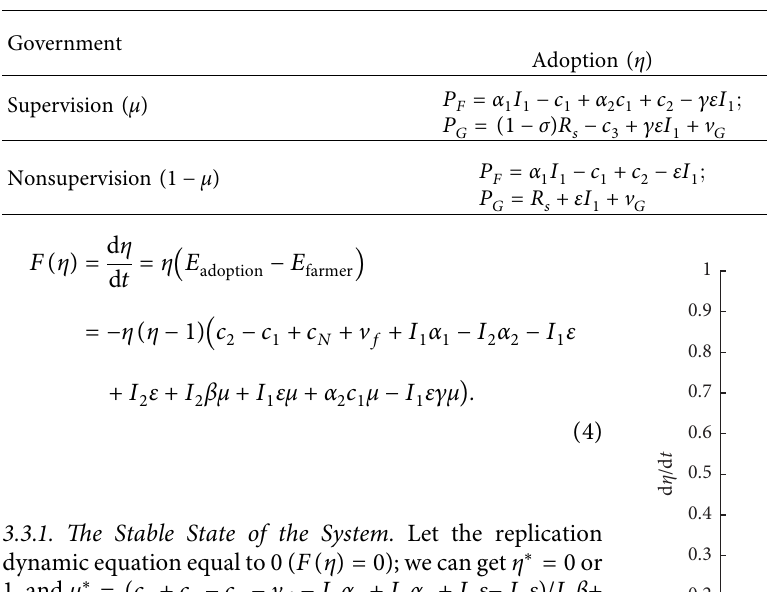
Table 2: The evolutionary game matrix.